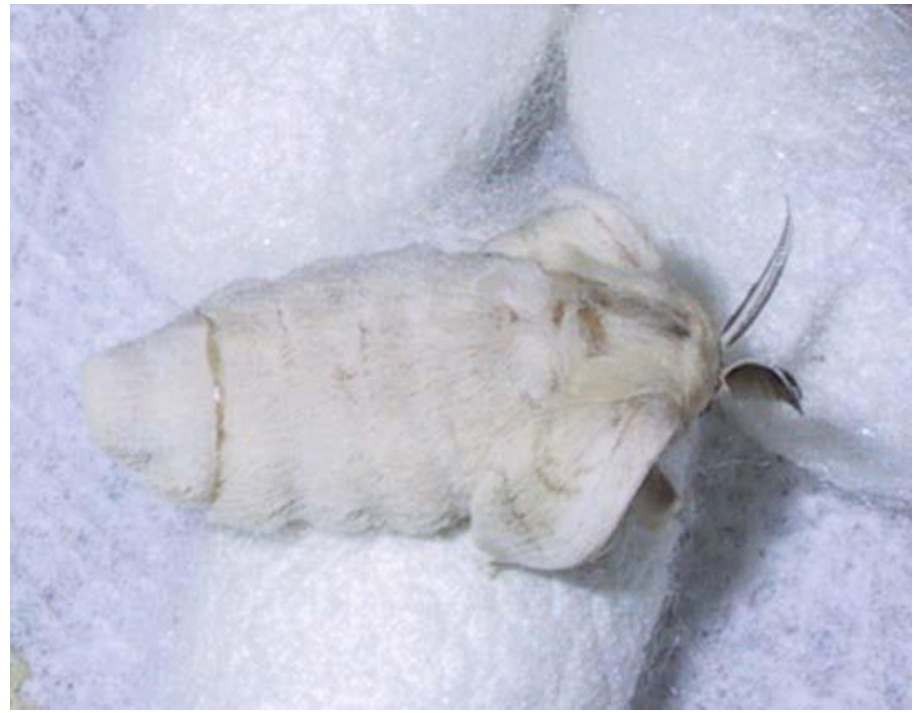
Figure 1. Female silkworm moth with tiny extended wings. Image copyright: Michael Cook, www.wormspit.com (accessed on 27 September 2022)